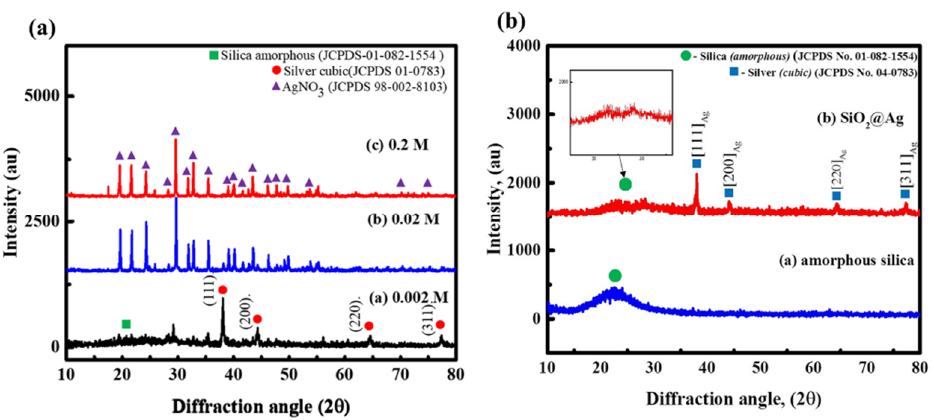
Figure 1. The XRD pattern of ( a ) different concentrations of AgNO 3 for Ag NPs’ formation and ( b ) amorphous silica with SiO 2 @Ag patterns. The amplified image indicated by the arrow reveals an amorphous silica peak.